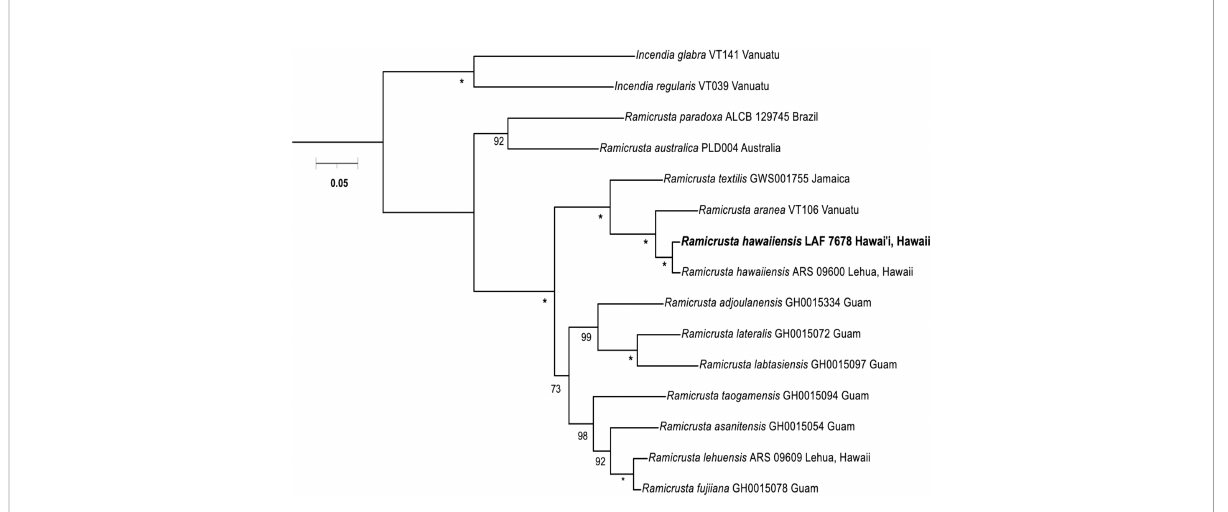
FIGURE 2 Concatenated COI and rbc L maximum-likelihood tree (2,035 bp) for Ramicrusta hawaiiensis and closely related species. Numbers along branches indicate nodal bootstrap support. Nodes with full support are indicated with an asterisk. Bootstrap support values less than 50 were omitted. Scale bar = substitutions per